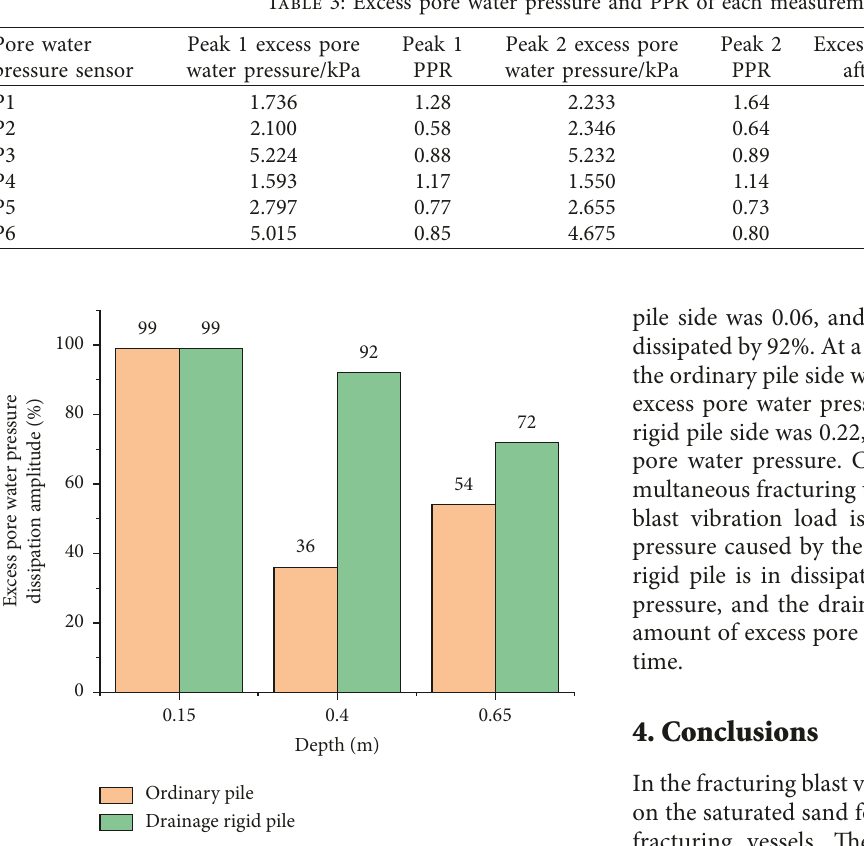
Figure 19: Dissipation magnitude of excess pore water pressure under the disposal of ordinary piles and drainage rigid piles for multiple fracturing blast vibration tests.